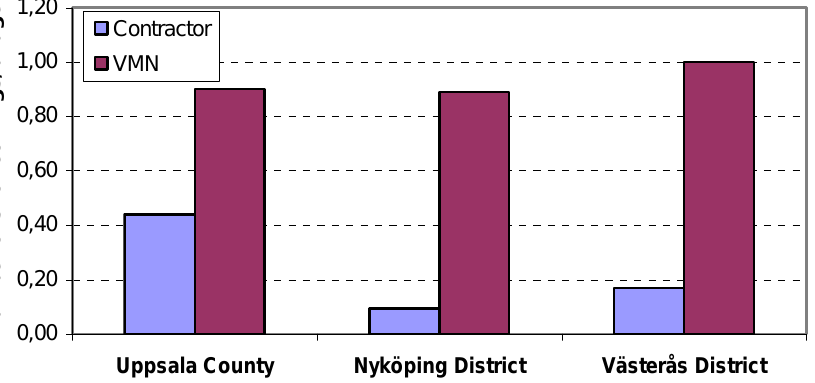
Figure 3. Number of shortcomings in properties found by the client (VMN) and the